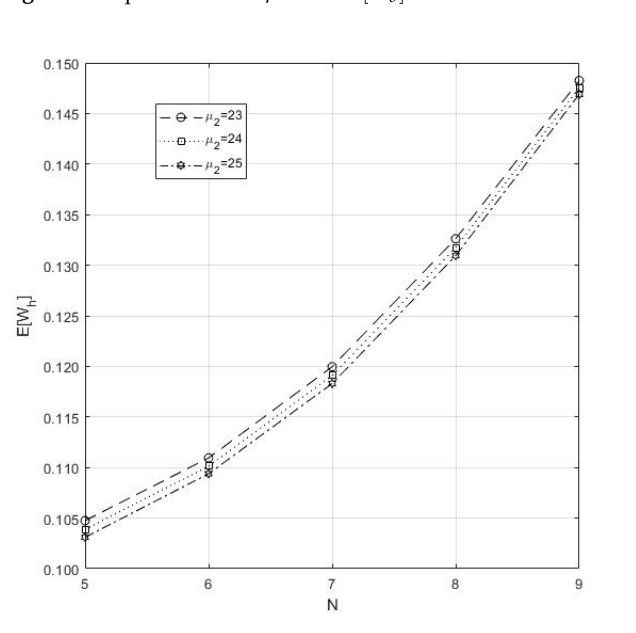
Figure 5. Impact of µ 2 and N on the E [ W h ]